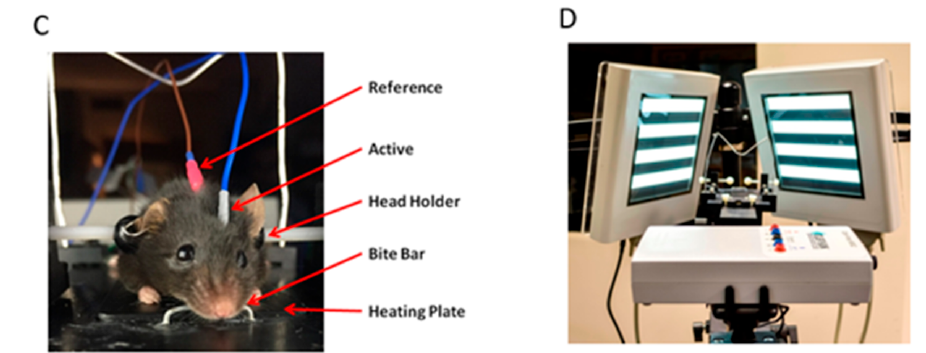
Figure 6. ( A ) Mouse PERG recording layout; ( B ) PERG waveforms simultaneously recorded from each eye using one common electrode in the snout; ( C ) Mouse with non-corneal subcutaneous needle electrodes resting on a feedback-controlled thermostatic plate; ( D ) Patterned visual stimuli generated on high luminance (800 cd/sqm) LED displays and presented at each eye independently with slightly different reversal frequency (right eye: 0.984 Hz; left eye: 0.992 Hz). Asynchronous averaging allows isolation of monocular PERGs.